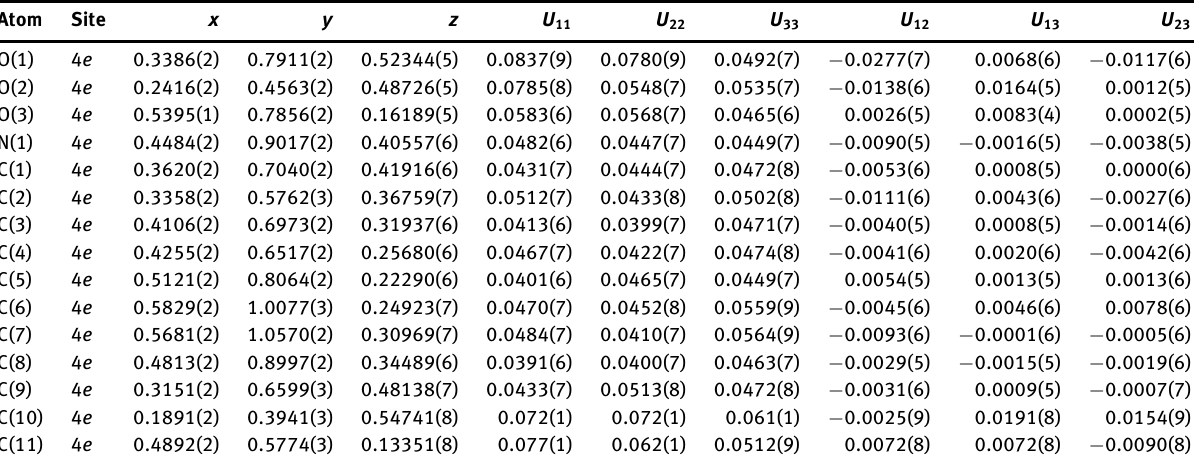
Table 3: Atomic displacement parameters (Å 2